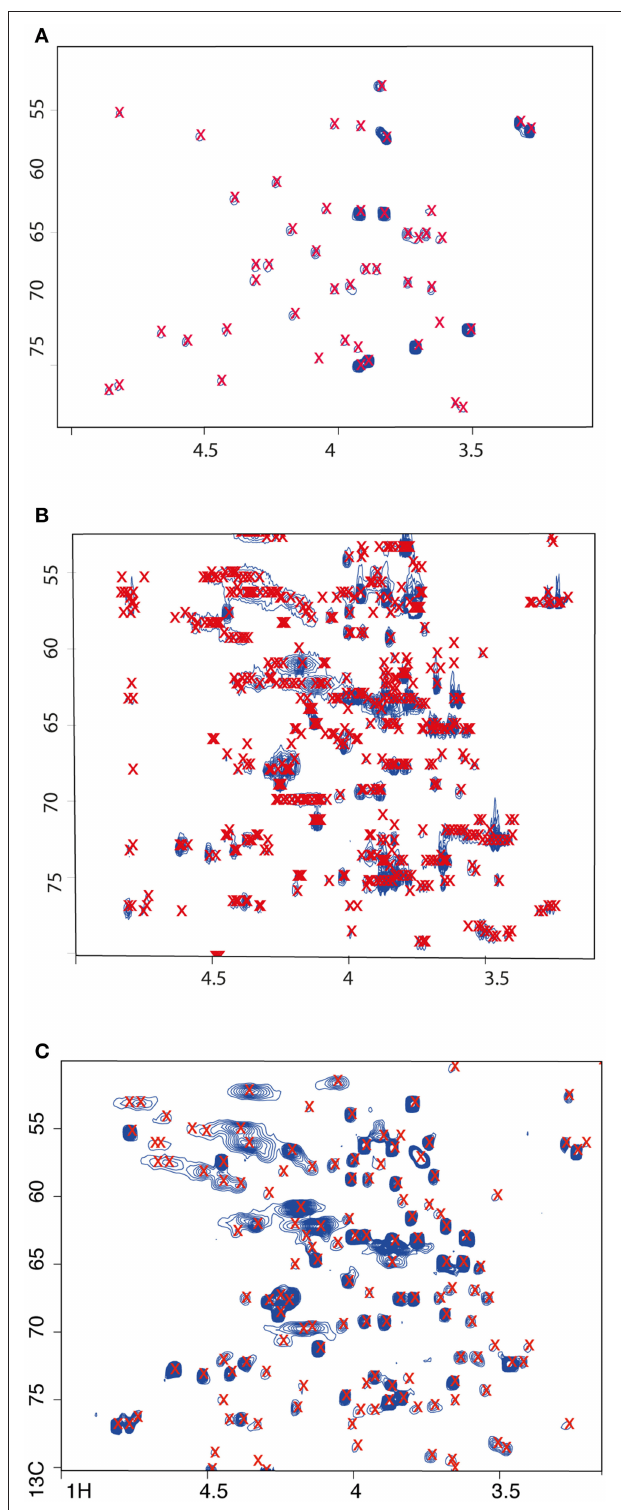
FIGURE 2 | The ct-HSQC (C) is better for peak detection using fully 13 C labeled C. elegans extracts than the standard sequence using either labeled (B) or unlabeled (A) samples. Detected peaks are labeled with a red x. Selected region of spectra shown